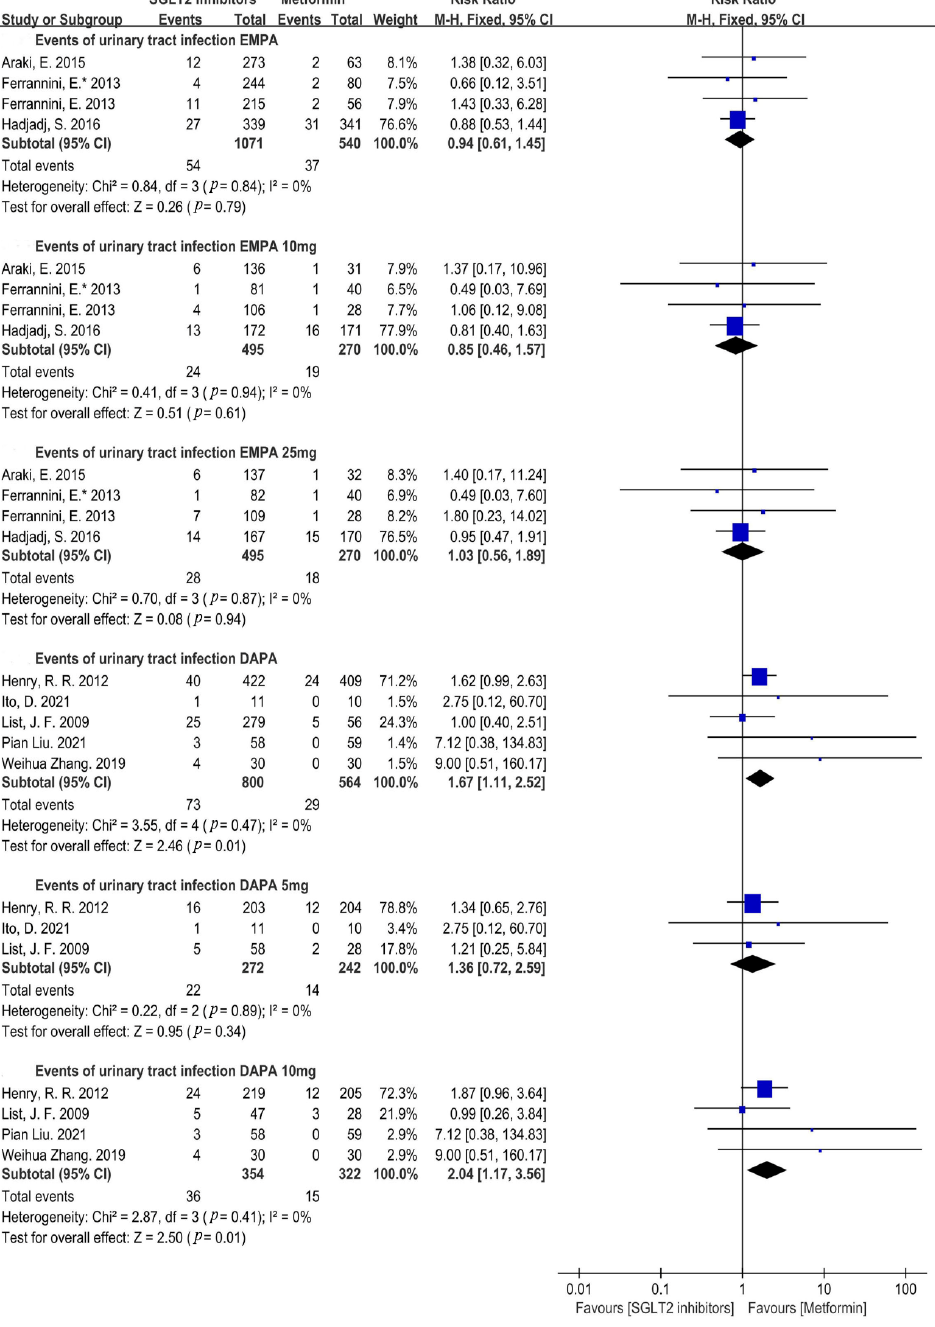
Figure 6. Risk of urinary tract infections with different types and doses of SGLT2i compared with that of metformin [20 – 28]. DAPA = dapagliflozin, EMPA = empagliflozin.